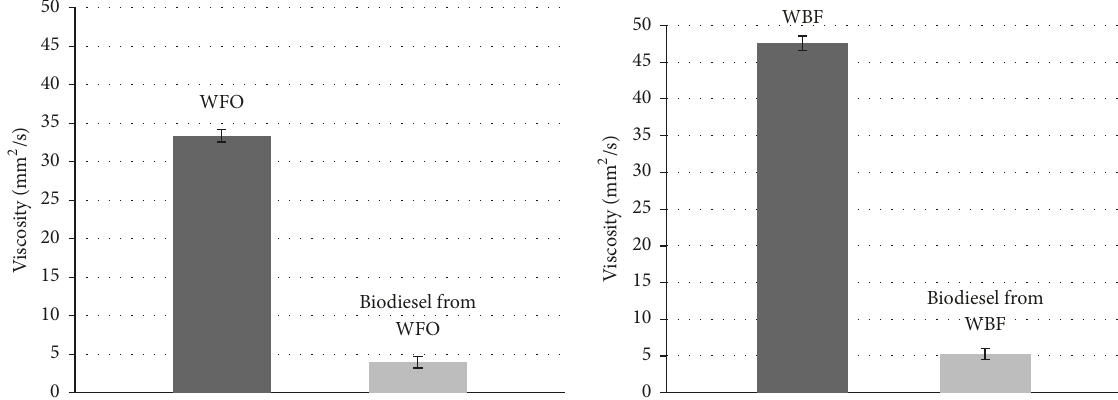
Figure 5: Viscosity of biodiesel before and after alkaline transesterification. WFO: waste frying oils, WBF: waste beef fats. Data are means ± SD of three independent